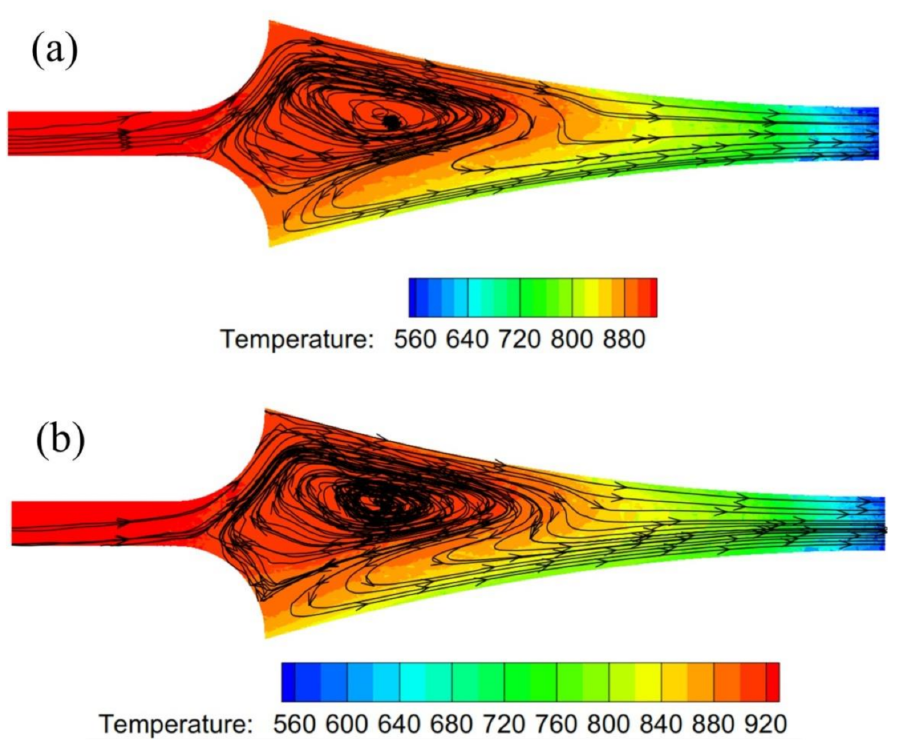
Figure 10. The flow field in the TRC and electromagnetic TRC process: ( a ) TRC; ( b ) electromag- netic TRC.